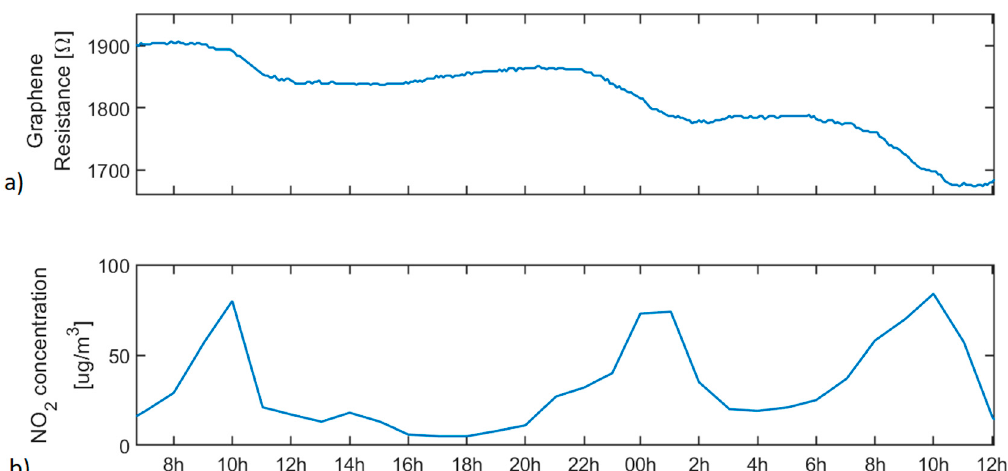
Figure 11. ( a ) Graphene sensor response during about 1 day of exposure to background level of NO 2 present in ambient atmosphere, and ( b ) NO 2 concentration registered by an automatic air quality station in Tarragona.